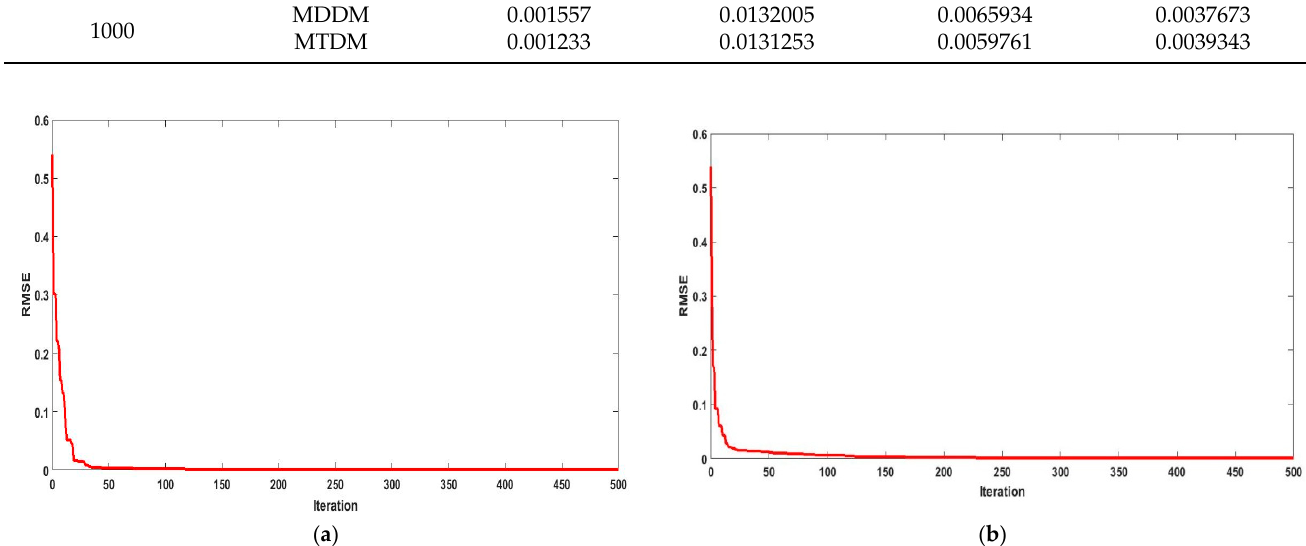
Figure 13. Convergence rates using EHO for 57 mm diameter commercial (R.T.C. France) silicon solar cell at 1000 W/m 2 and 306 K; ( a ) for MDDM, ( b ) for MTDM.